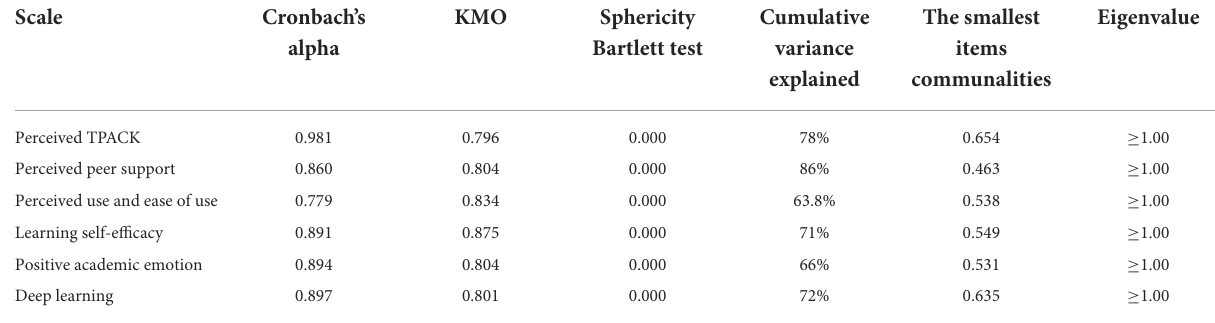
TABLE 7 Pilot study